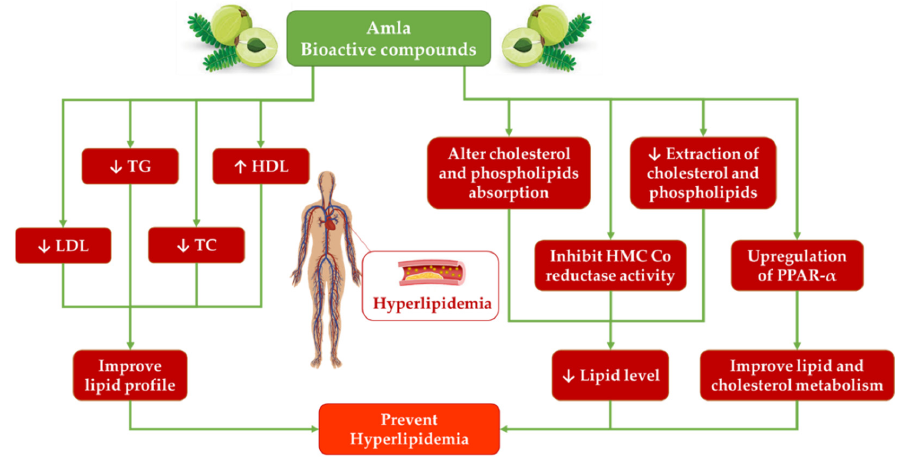
Figure 2. Anti-hyperlipidemic role of